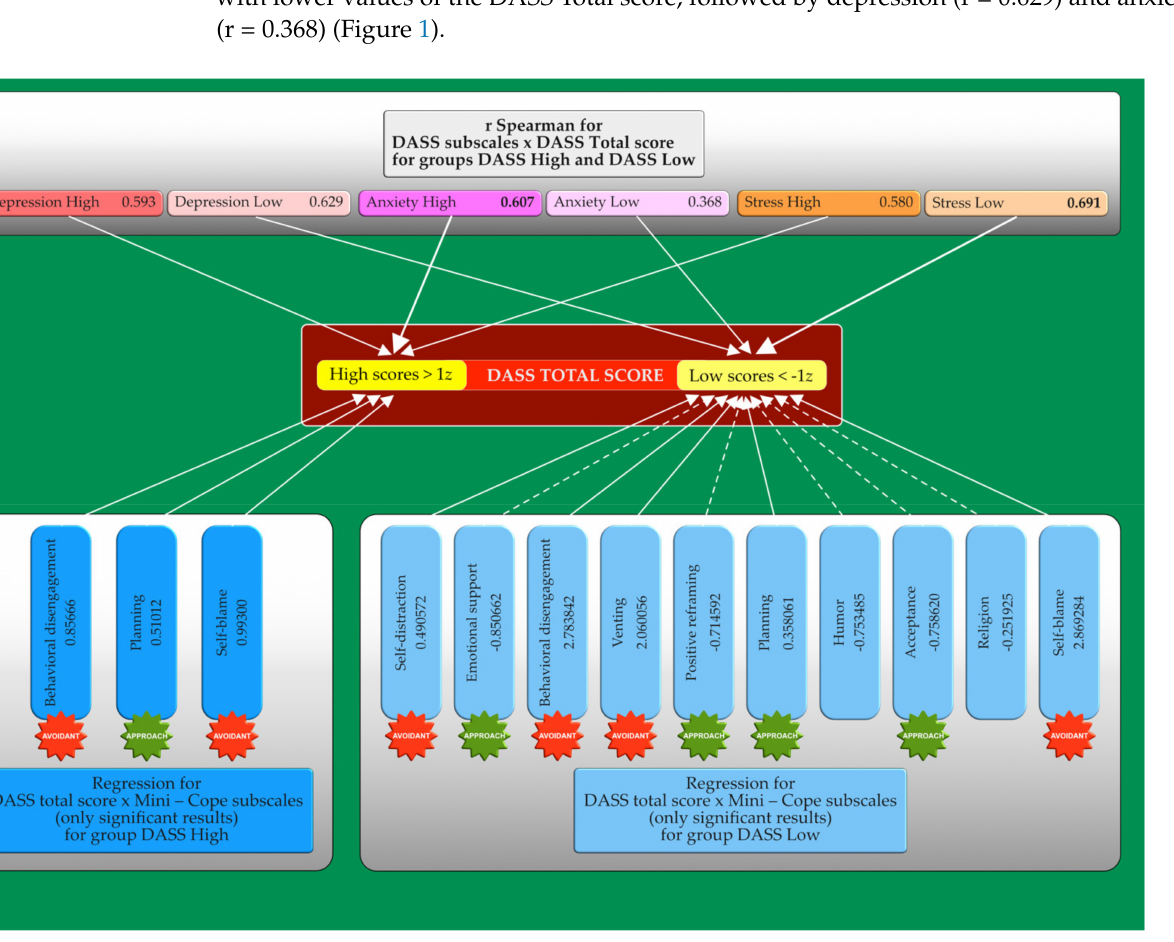
Figure 1. The impact of the stress coping strategies and DASS subscales on the emotional well-being (DASS Total score) of Polish